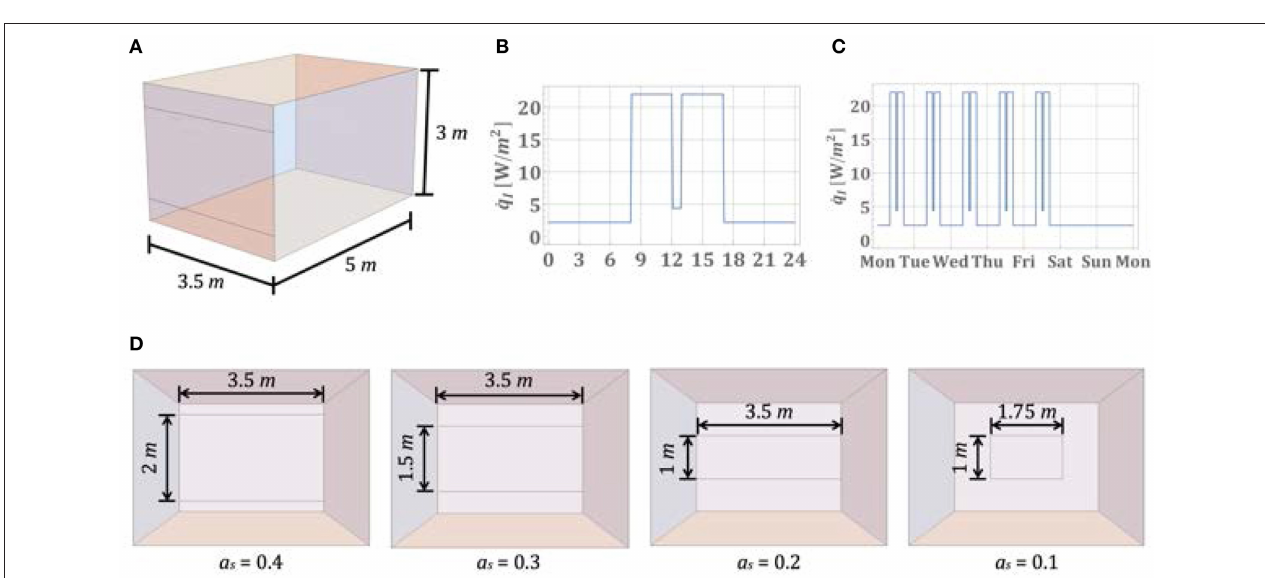
Frontiers in Materials |